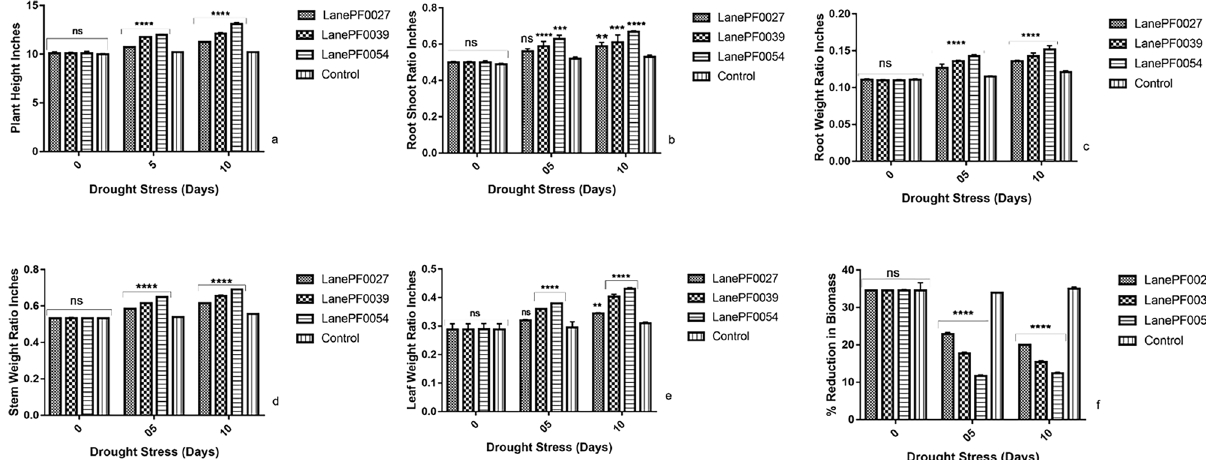
Figure 7. Effect of drought stress on growth indicators of transgenic cotton plants with GaZnF gene. ( a ) Comparison of plant height of transgenic and control plants, ( b ) Comparison of root shoot ratio of transgenic and control plants, ( c ) Comparison of root to total plant weight ratio of transgenic and control plants, ( d ) Comparison of stem to total plant weight ratio of transgenic and control plants, ( e ) Comparison of leaf to total plant weight ratio of transgenic and control plants, ( f ) Comparison of percentage of reduction in biomass of transgenic and control plants. The means ± SD of three biological replicates are presented. Error bars represent the standard deviation of the mean. Above the bars ****, ***, **represent significant and ns represent non- significant differences between transgenic and non-transgenic plants respectively at the P < 0.05 level according to LSD multiple range